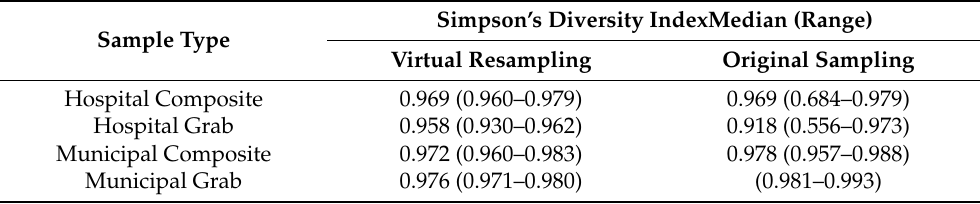
Table 2. Simpson’s diversity index after virtual resampling in comparison to original